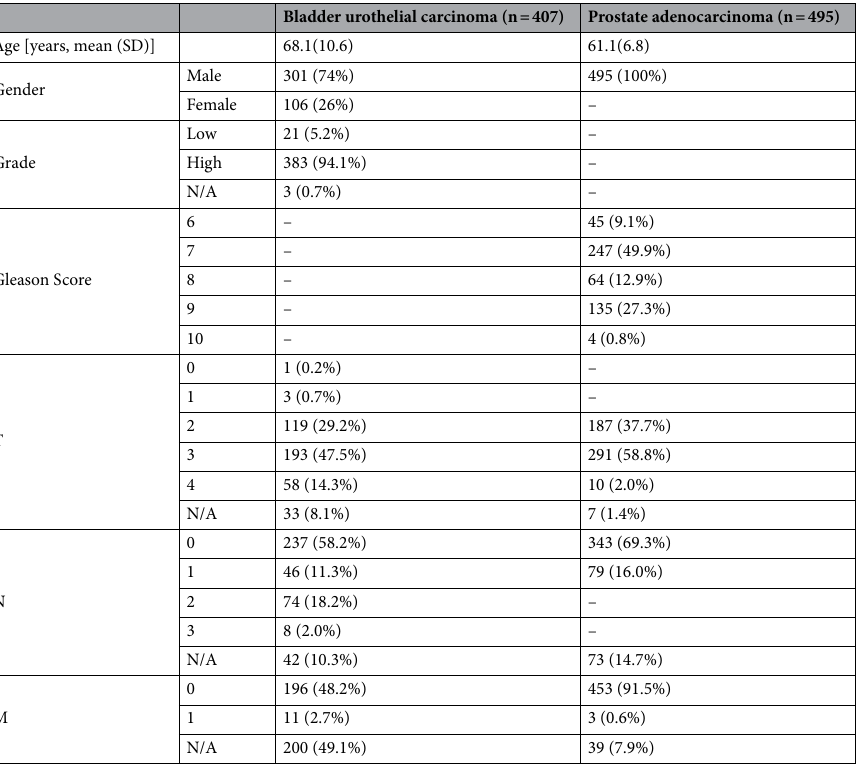
Table 1. Clinical characteristics of bladder urothelial carcinomas and prostate adenocarcinomas. N/A not